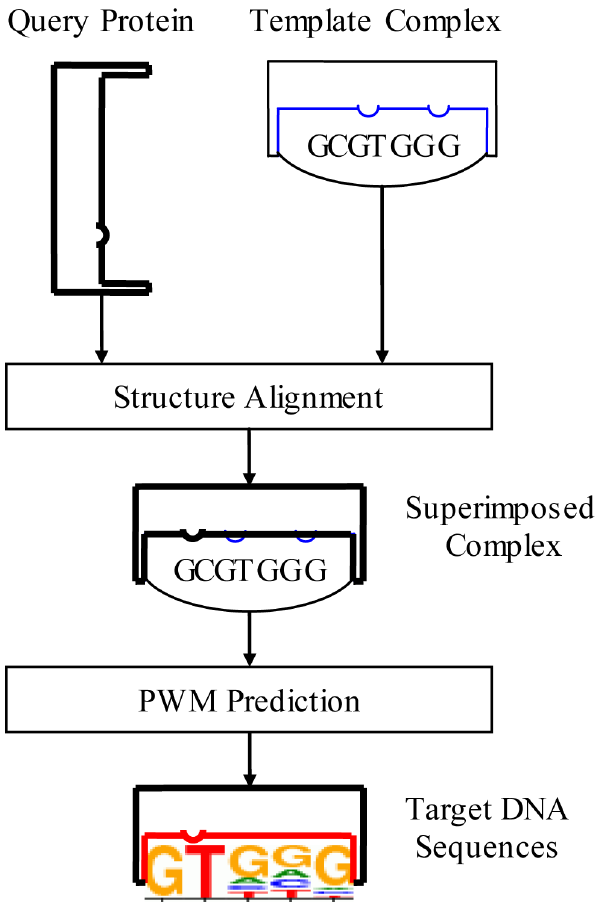
Figure 1. The workflow of the proposed method. The query protein is superimposed onto the specified template structure and then the PWM prediction is performed on the superimposed protein-DNA complex based on a knowledge-based potential function considering atomic contacts.